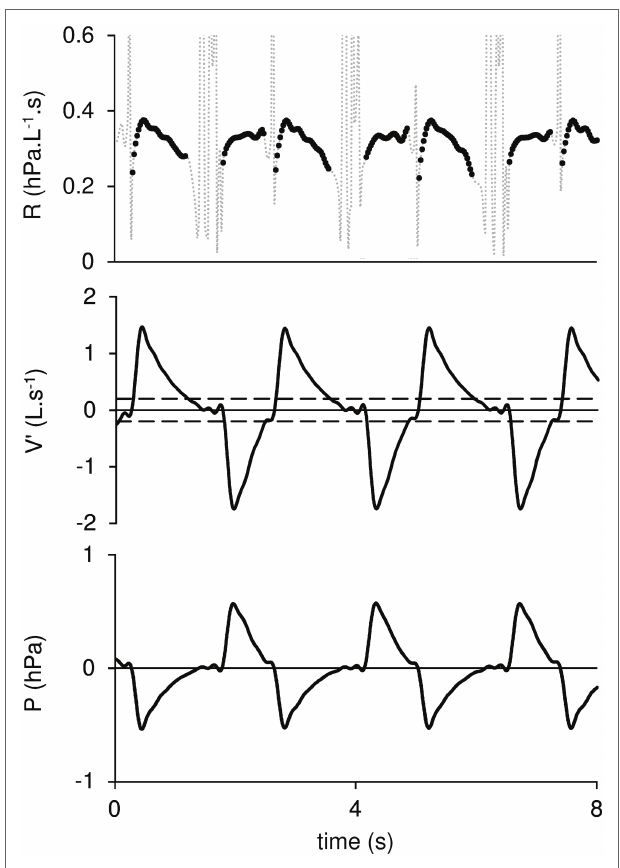
FIGURE 2 | Mask resistance (R), Flow (V ′ ), and pressure (P) are plotted against time. The dotted lines on R tracing correspond to data rejected from the computation. Horizontal broken lines on V ′ indicate the − 0.2 L.s − 1 to +0.2 L.s − 1 interval beyond which R values are rejected. Positive V ′ values indicate inspiration.